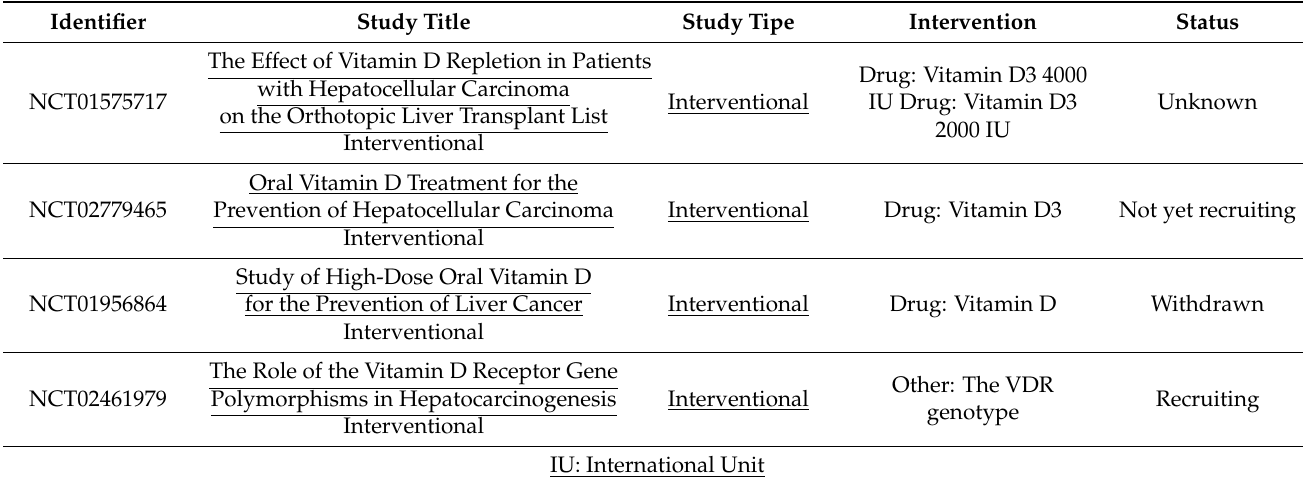
Table 2. Summary of clinical trials from